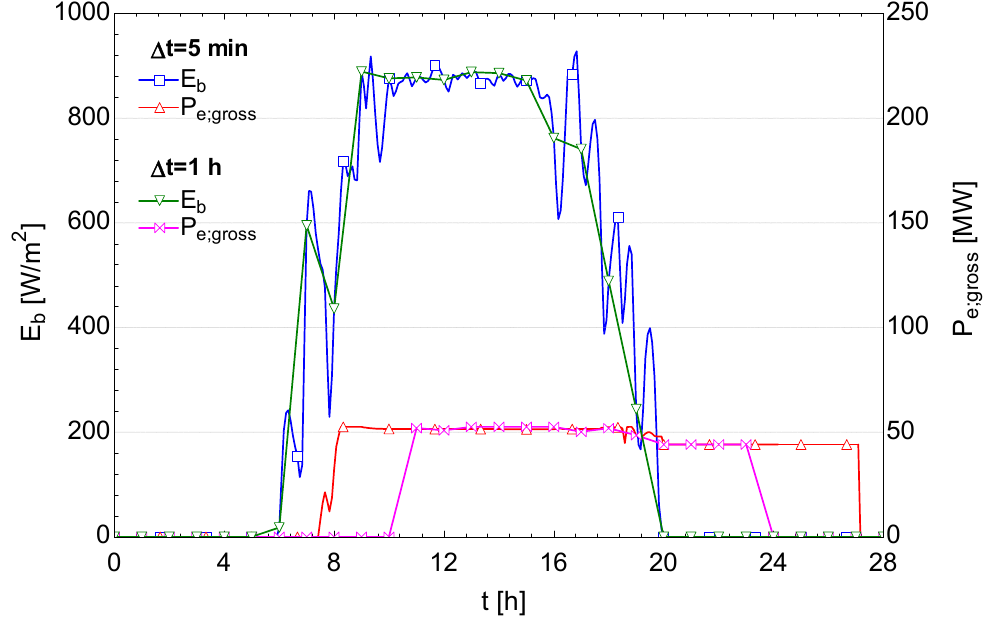
Figure 4. Comparison of the direct normal irradiance ( E b ) and gross electric power production ( P e , gross ) obtained with 5 min and 1 h time step simulations for 22 June.